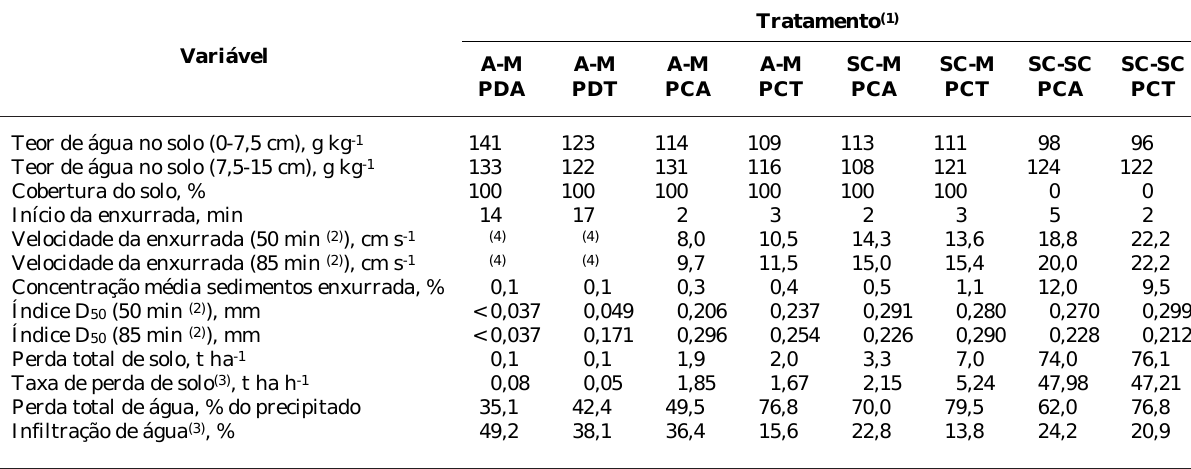
Quadro 4. Valores das variáveis relacionadas com a erosão, obtidos na chuva (intensidade constante de